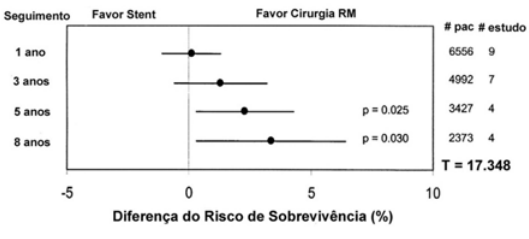
Fig. 2 - Metanálise de 9 trials randomizados e controlados: “Stent” x Cirurgia de revascularização do miocárdio em doença multiarterial - Guyton, 2006 [2]